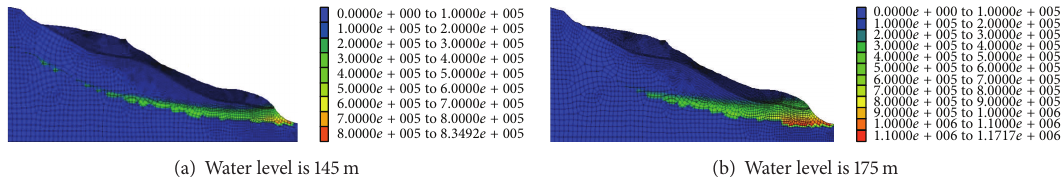
Figure 11: Calculation results of the seepage